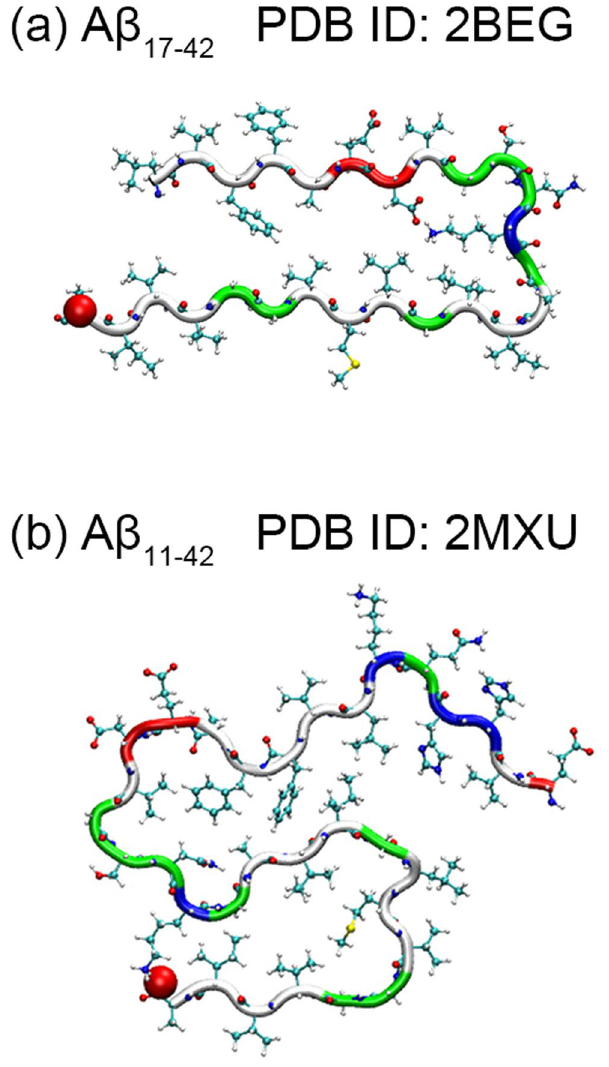
Figure 1. Polymorphism in A β fibrils. Single fold U-shaped ( a ) and S-shaped ( b ) A β 42 fibril